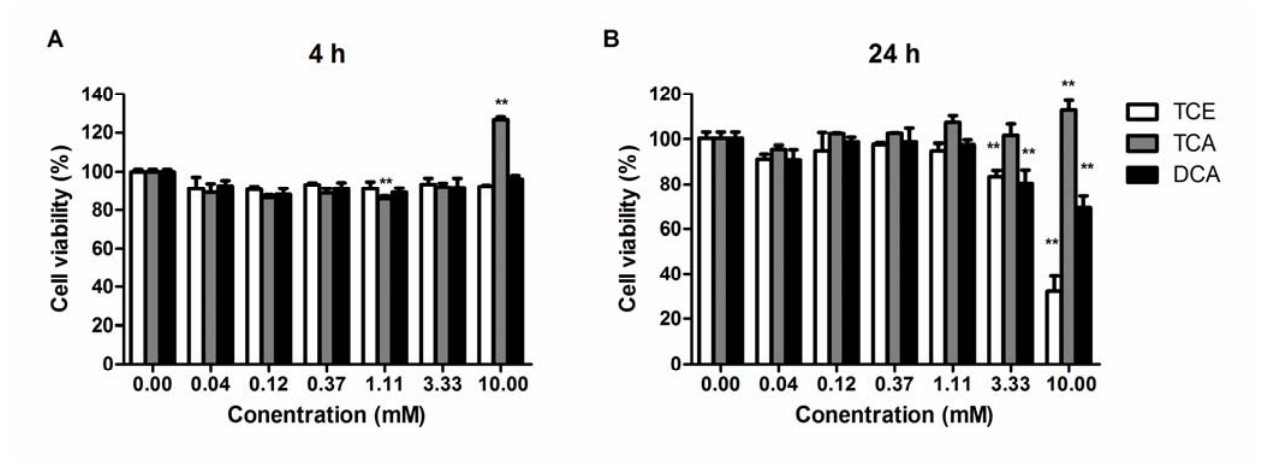
Figure 1. Effect of trichloroethylene (TCE), trichloroacetic acid (TCA) and dichloroacetic acid (DCA) on the cell viability of Jurkat cells. Cells were treated with TCE, TCA and DCA combined with the stimulation of phorbol 12-myristate 13-acetate (PMA) (50 ng/mL) and ionomycin (Ion) (1 mM) for 4 h ( A ) and 24 h ( B ) at 37 °C. Cell viability was then determined by the CellTiterGlo ® luminescent cell viability assay, and the results are shown as the mean ± SD of three independent experiments. ** p < 0.01 compared to the DMSO vehicle control